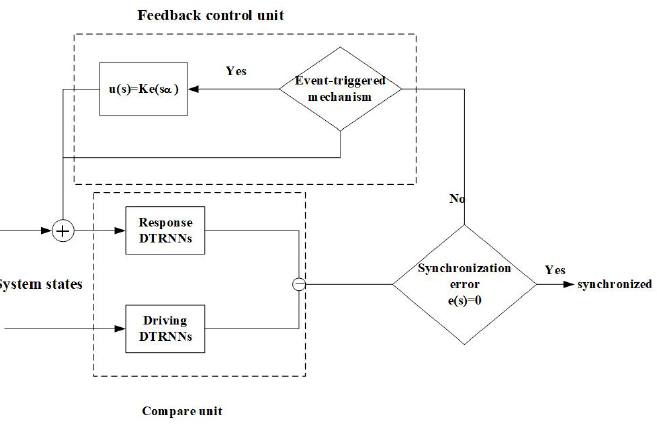
Figure 1. Synchronization flow chart for